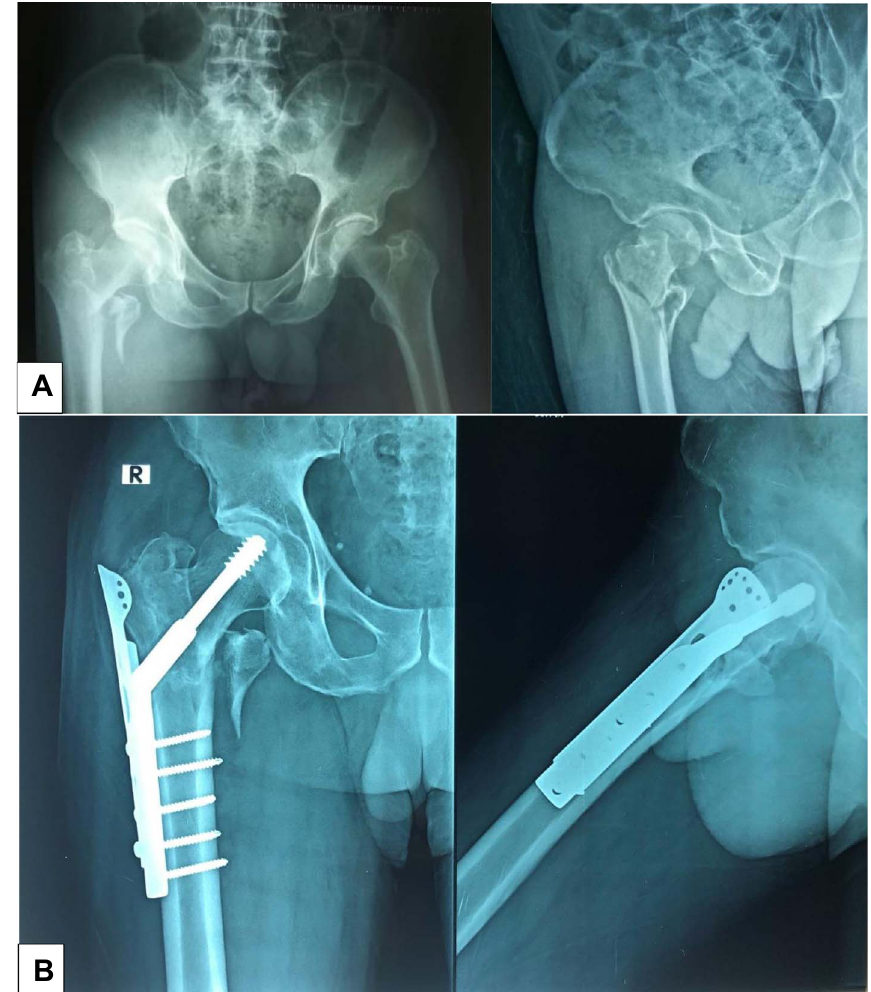
Figure 1. X-rays of 63-year-old male patient with AO 31A2.2 pertrochanteric fracture (lateral wall thickness < 20 mm) managed by DHS with TSP: (A) Pre-operative X-rays; (B) X-rays at 6 months